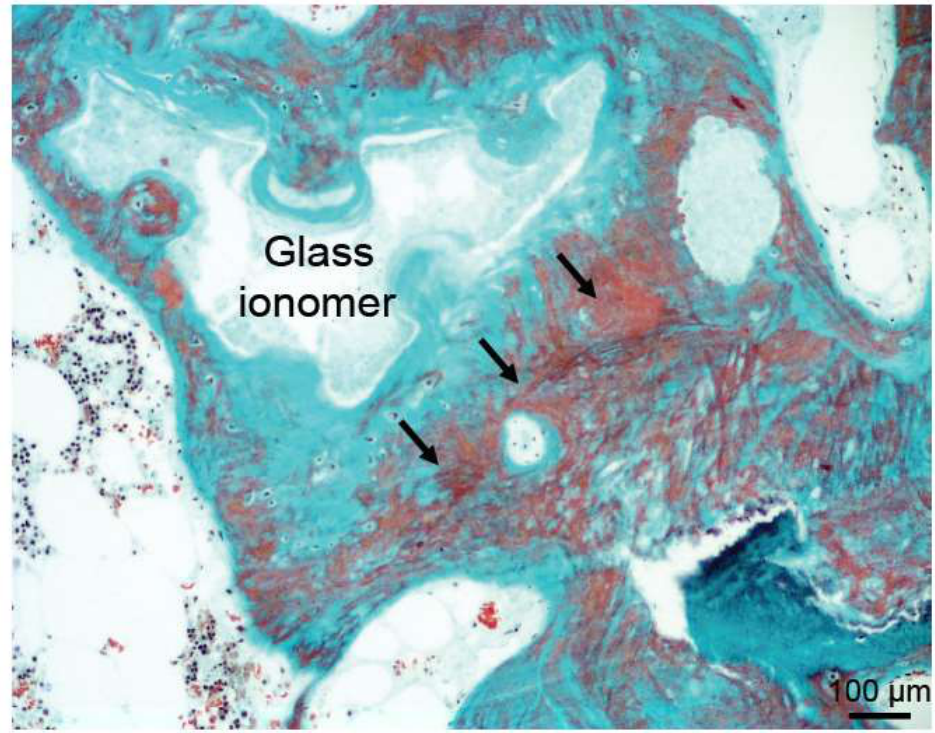
Figure 7. Image of a trichrome Goldner stained section showing bone growth around glass ionomer cement. However, this bone is characterized by large areas of non-mineralized bone (osteoid, black arrows), contributing to insufficient bone stability.